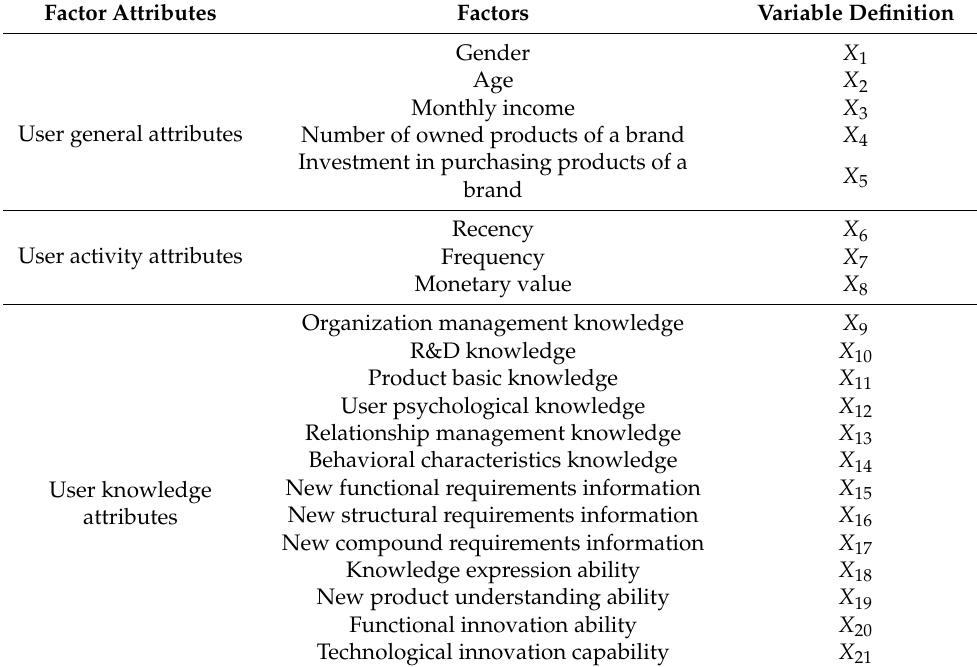
Table 1. Factor set for lead user